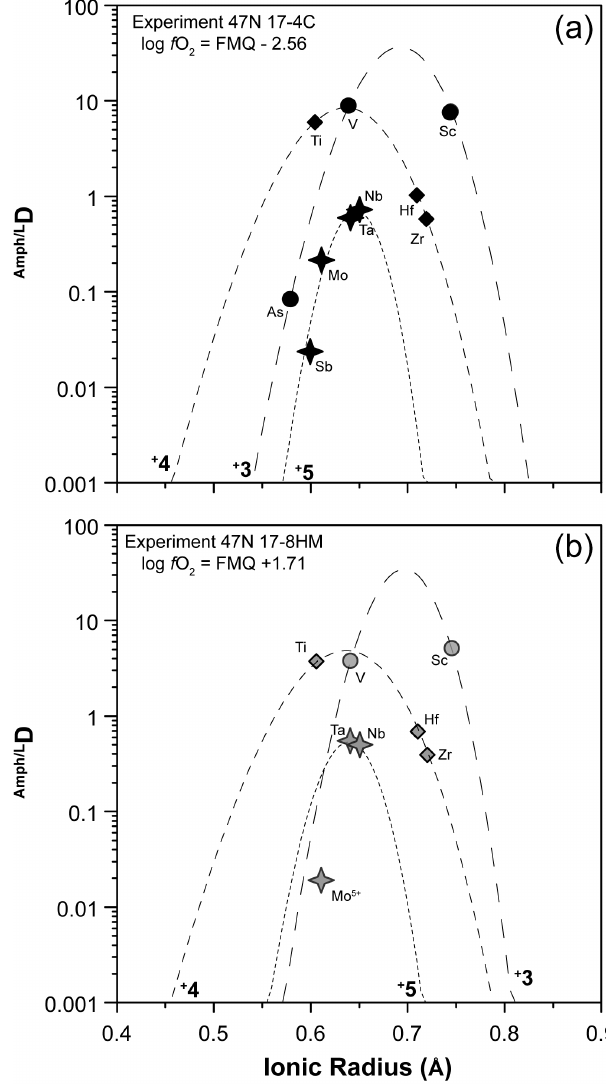
Figure 10. Measured partition coefficients and fitted solution to the lattice-strain model for the M (1–3) site (i.e., Onuma diagrams) in amphibole of experiments 17-4C (a) and 17-8HM (b) as represen- tative of low and high f O 2 conditions, respectively (data in Ta- ble 6). Ionic radius data (in Å) from Shannon (1976). To note is that the parabola for 5 + cations for experiment 17-8HM assumes that Young’s modulus does not change significantly with f O 2 , as sug- gested by the similarity in the Young’s modulus for 4 + cations that are more constrained for experiments at both f O 2 conditions (see Table